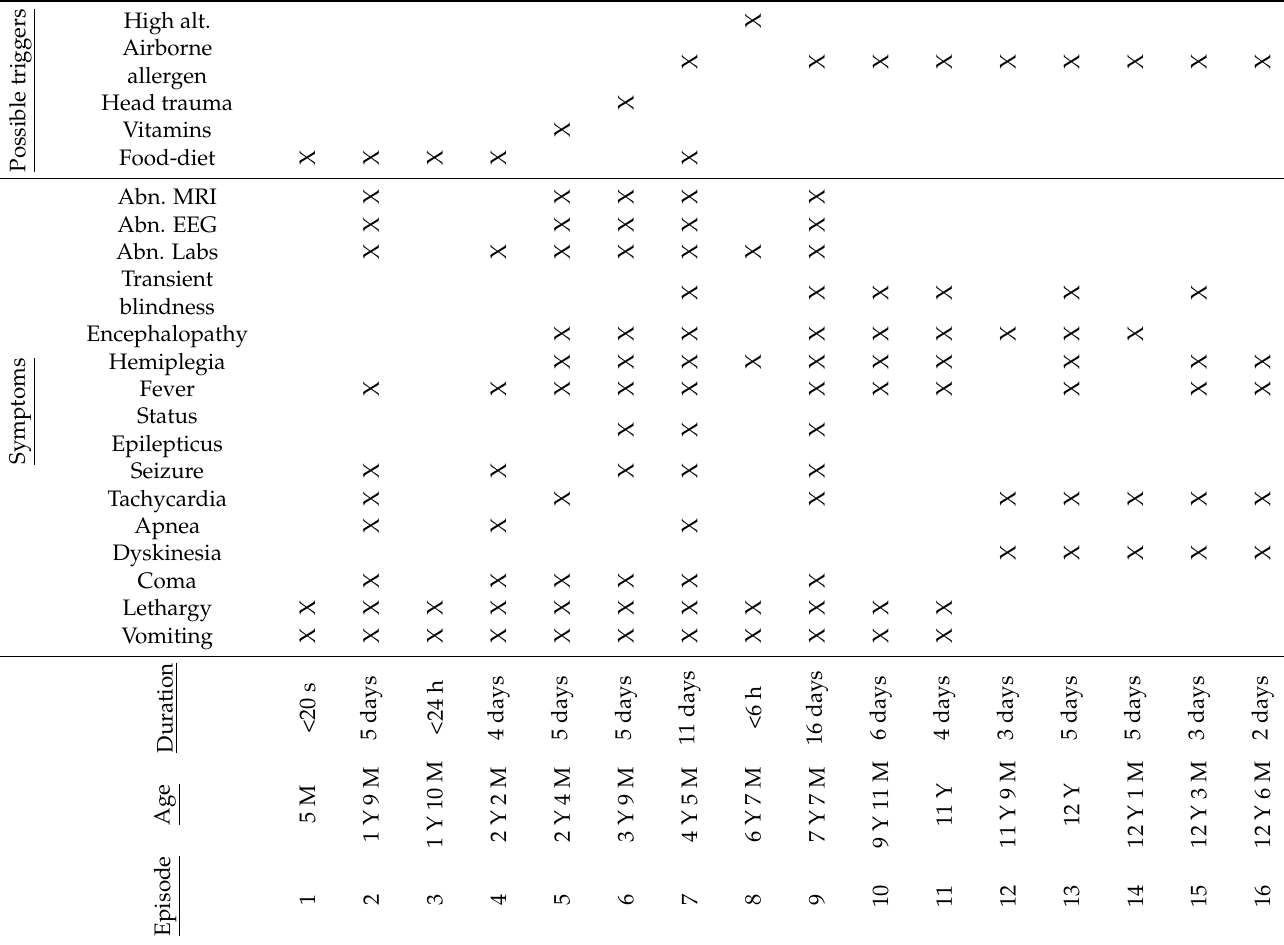
Table 2. Description of each attack in chronological